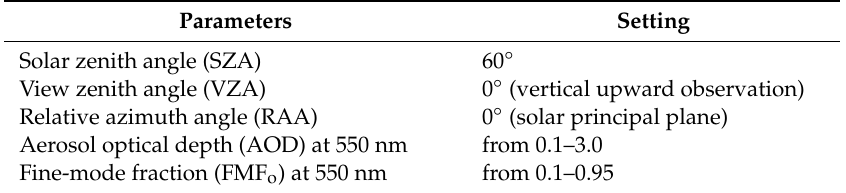
Table 4. The parameter settings for the simulation of analog